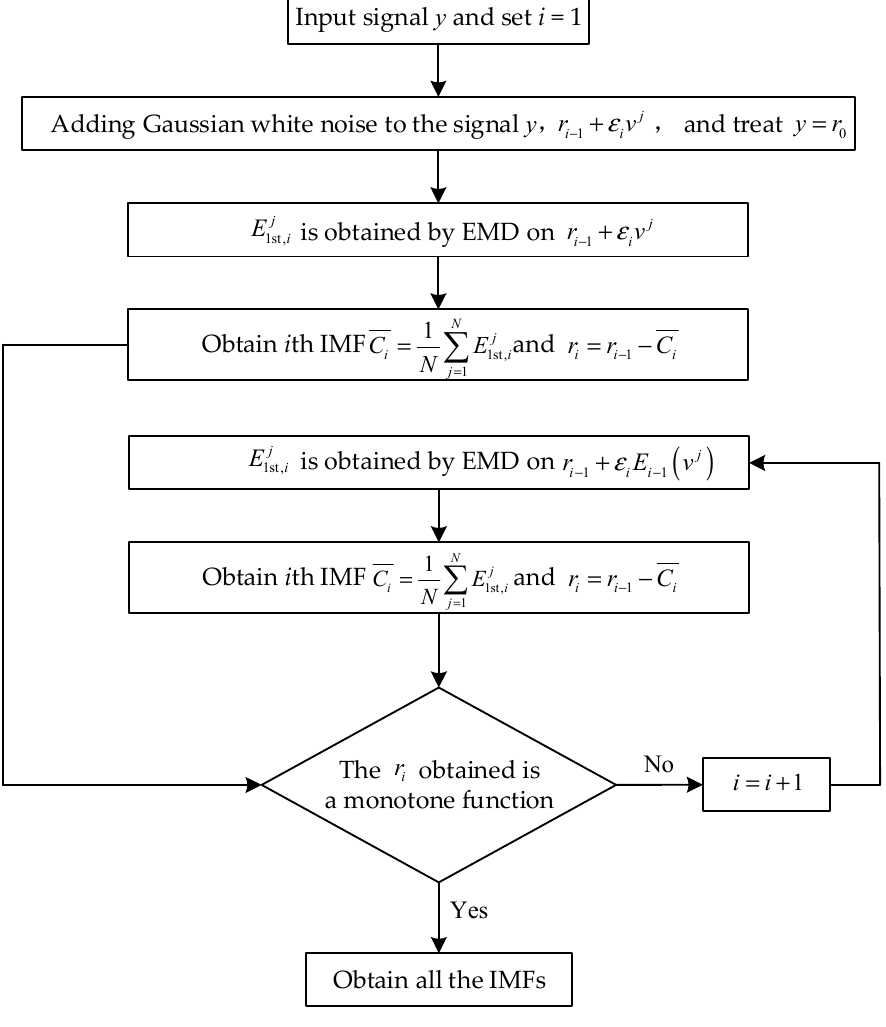
Figure 3. Flow chart of the CEEMDAN algorithm.